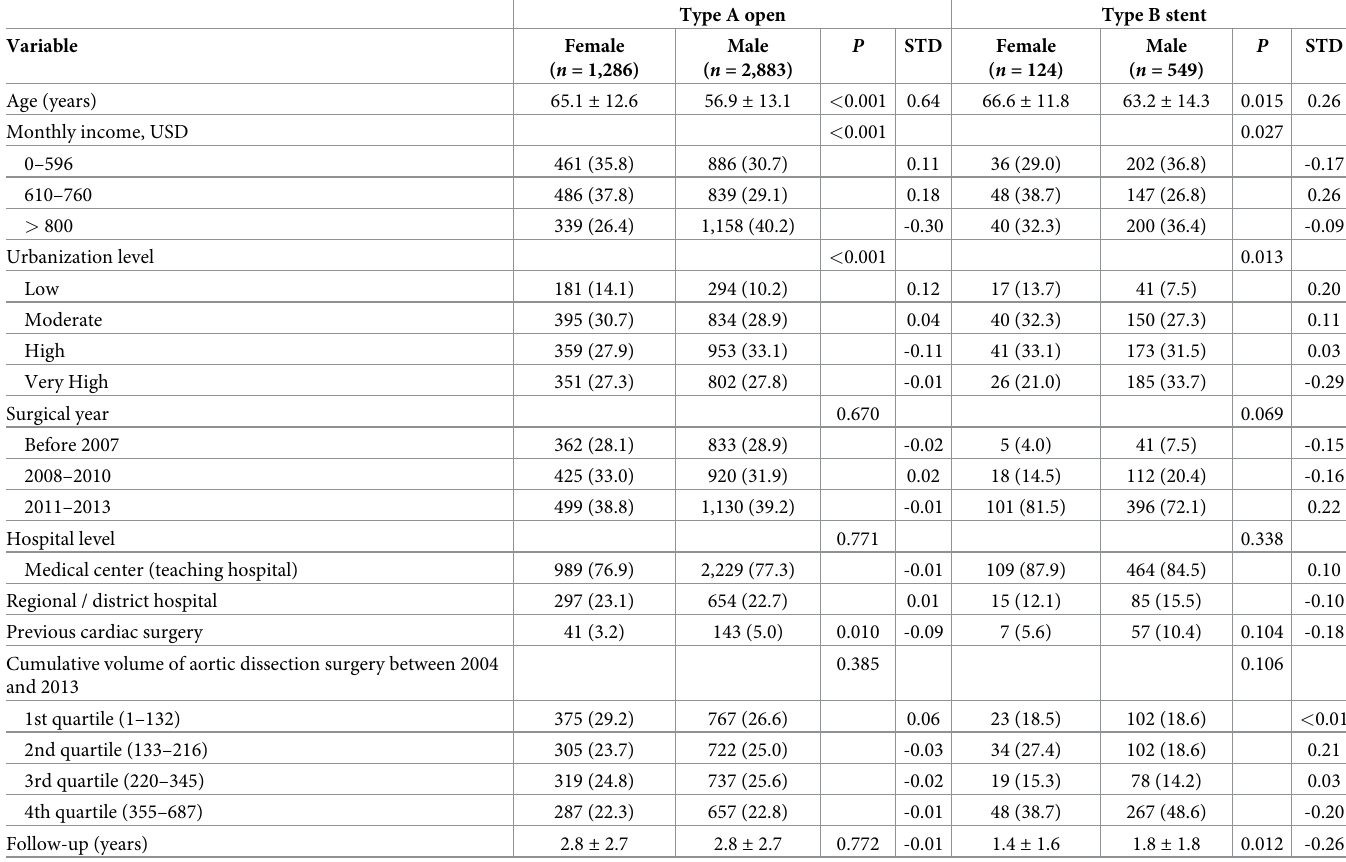
Table 1. Patient demographics and institution characteristics of the female and male patients who received AAD surgery before propensity score